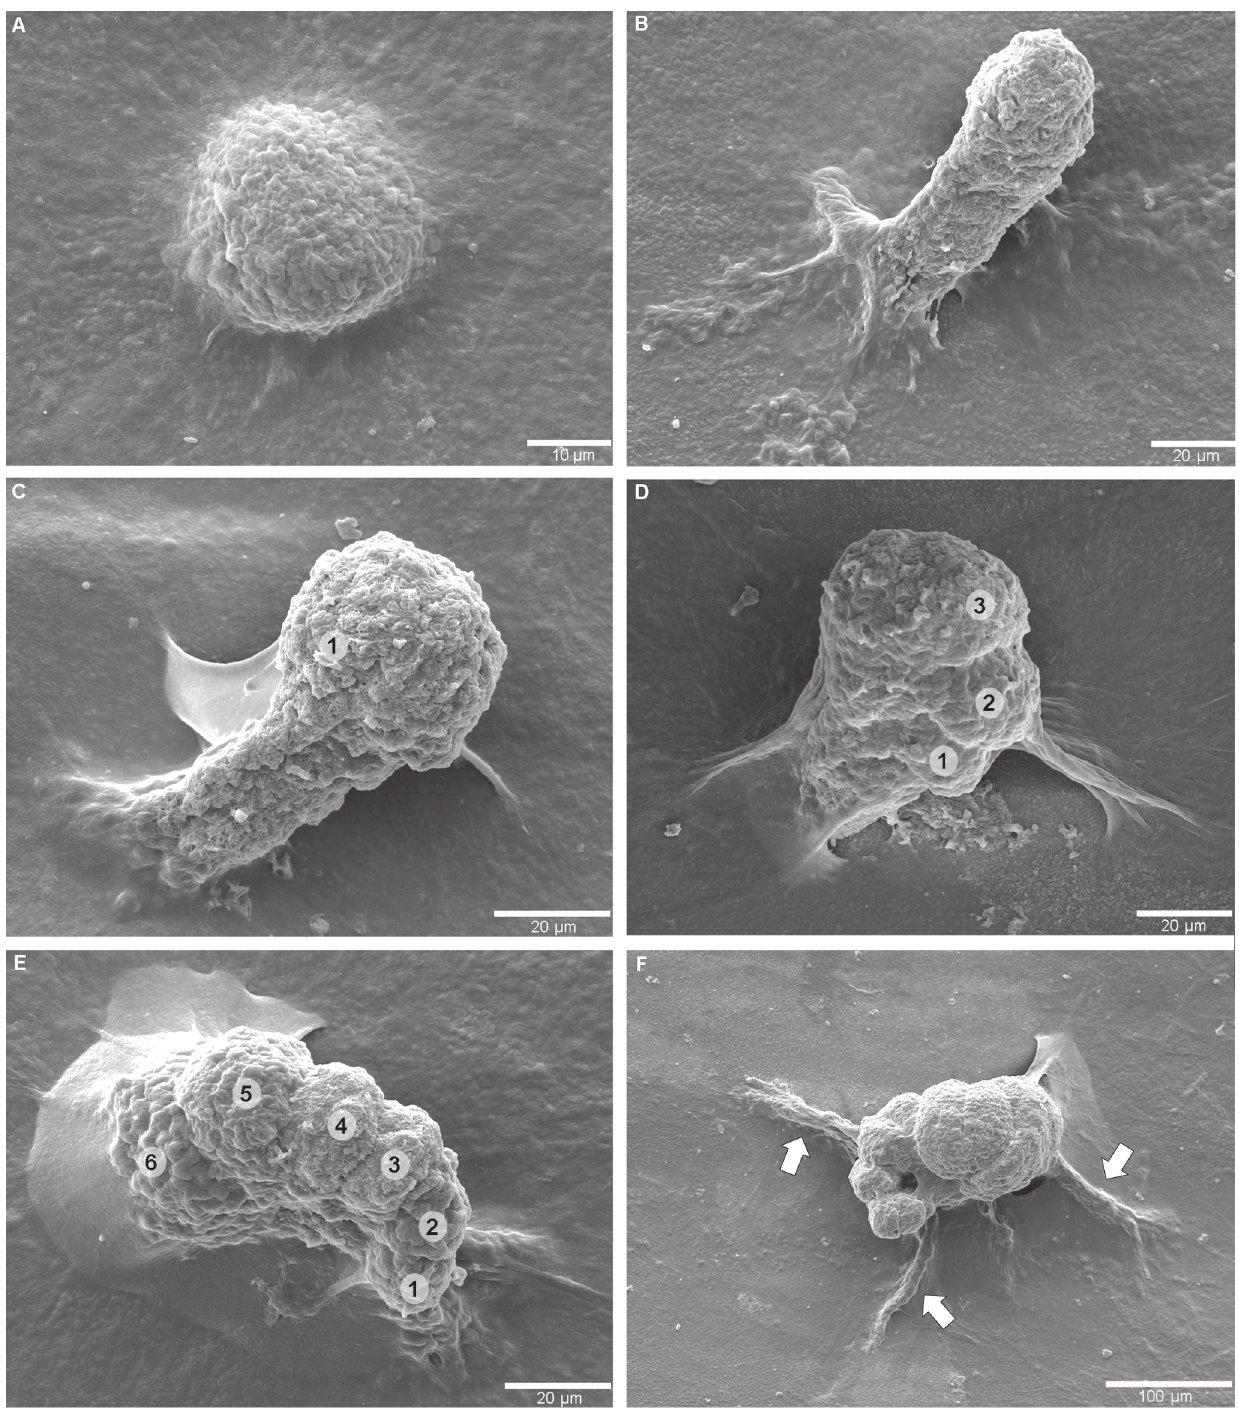
Fig 4. Ontogeny of Morphotype 3 in Nautilus macromphalus from New Caledonia as seen in SEM images of epoxy-resin casts. (A) Initial boring. (B) An initial tunnel is bored into the substrate. (C) The termination of the stalk forms the first swelling ( ① ). (D) The trace continues to extend into the substrate and begins to form incremental lateral swellings ( ① – ③ ). (E) The number of increments arranged as a spiral increases ( ① – ⑥ ). (F) Mature morphology with a spiral of numerous increments, a large chamber, and connections to the substrate via radiating rhizoidal galleries (arrows).